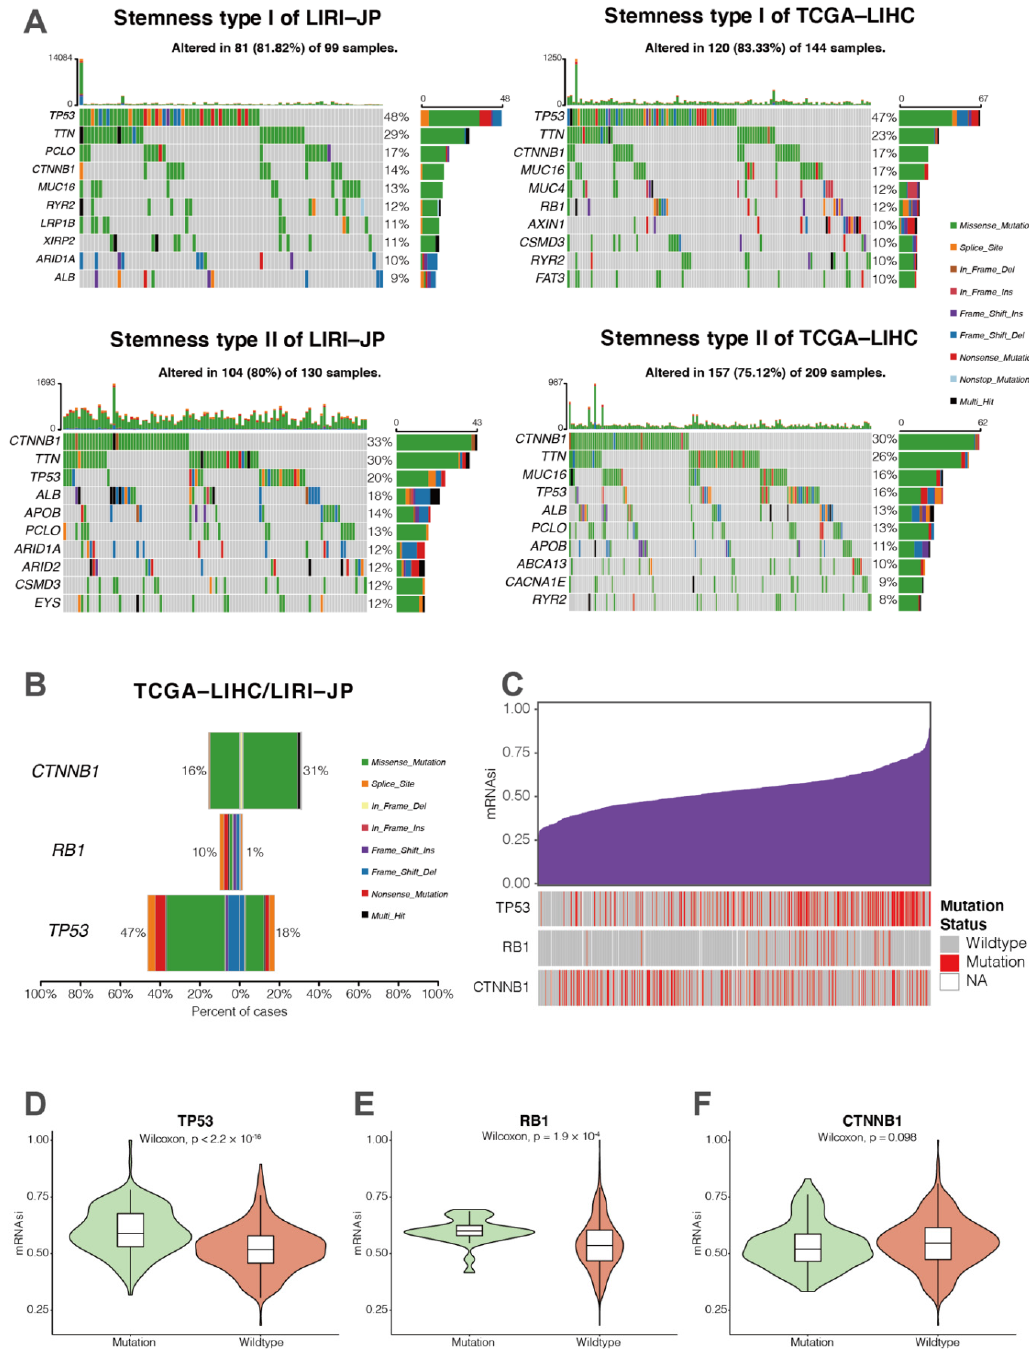
Figure 6. Comparisons of somatic mutations between HCC stemness subtypes. ( A ) Waterfall plots showing the top 10 mutated genes of HCC stemness subtype I ( top ) and II ( bottom ) in the LIRI-JP ( left ) and TCGA-LIHC ( right ) cohorts, respectively. ( B ) Most differentially mutated genes between HCC stemness subtypes in the LIRI-JP and TCGA-LIHC cohorts. ( C ) Overview of the association between mRNAsi and several somatic mutations (i.e., TP53, RB1, and CTNNB1) in HCC patients from the LIRI-JP and TCGA-LIHC cohorts. Columns represent samples sorted by mRNAsi. Rows represent somatic mutations associated with mRNAsi. ( D – F ) Violin plots of mRNAsi of HCC patients classified by the mutation status of TP53, RB1, and CTNNB1.